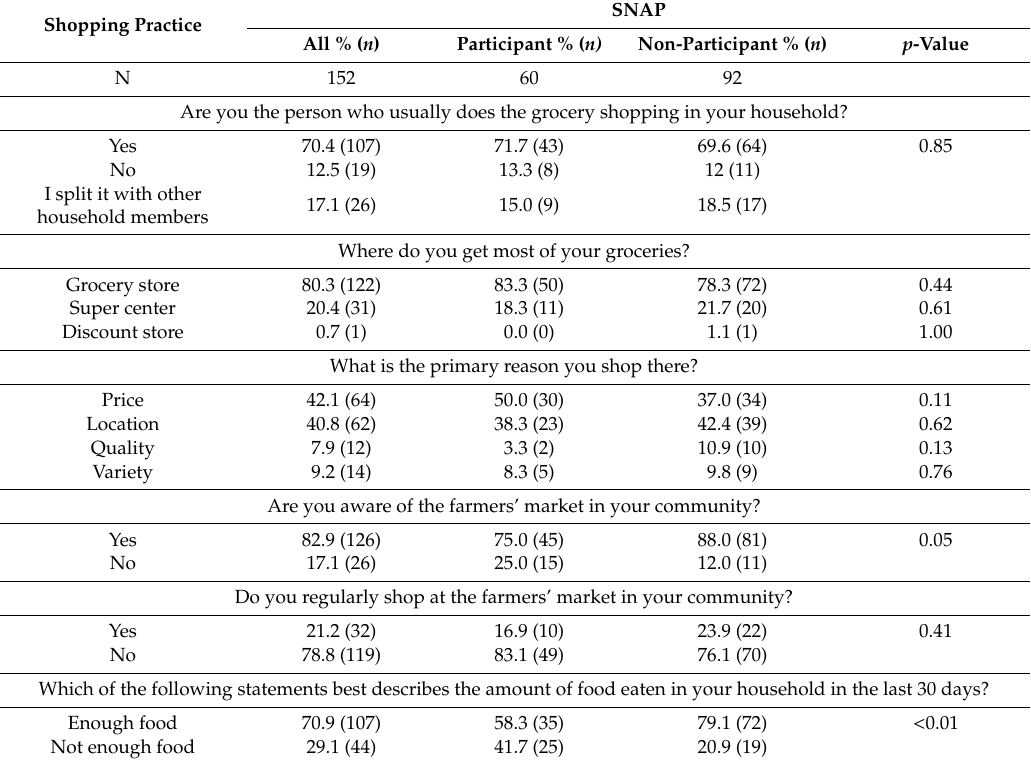
Table 2. Di ff erences in shopping practices and food security status by SNAP participation (N =